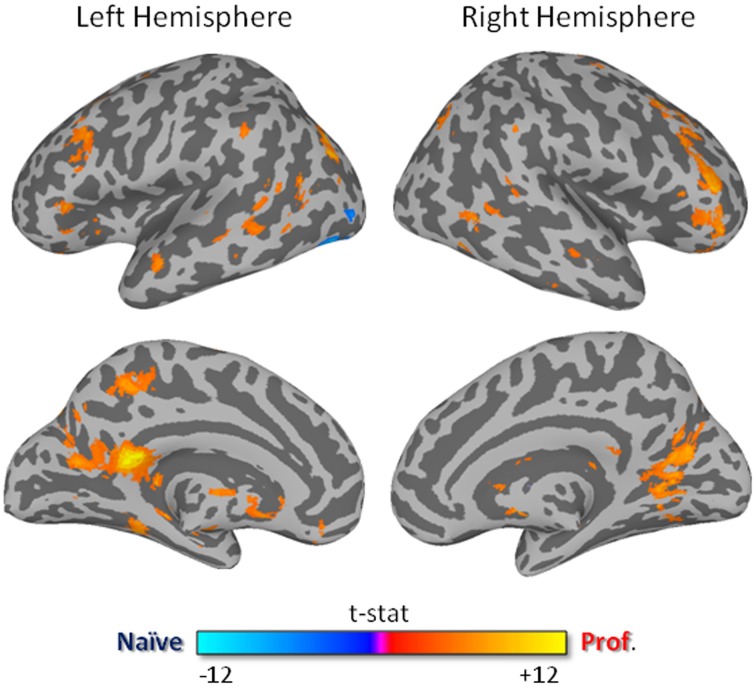
Contrast between ISC-values of naïve and professional drivers. The dark/light blue color indicates a higher correlation value in the naïve drivers, while red/yellow colors indicate a higher correlation in the professional drivers (p < 0.01, FDR corrected, minimum cluster size is set to 30 voxels).